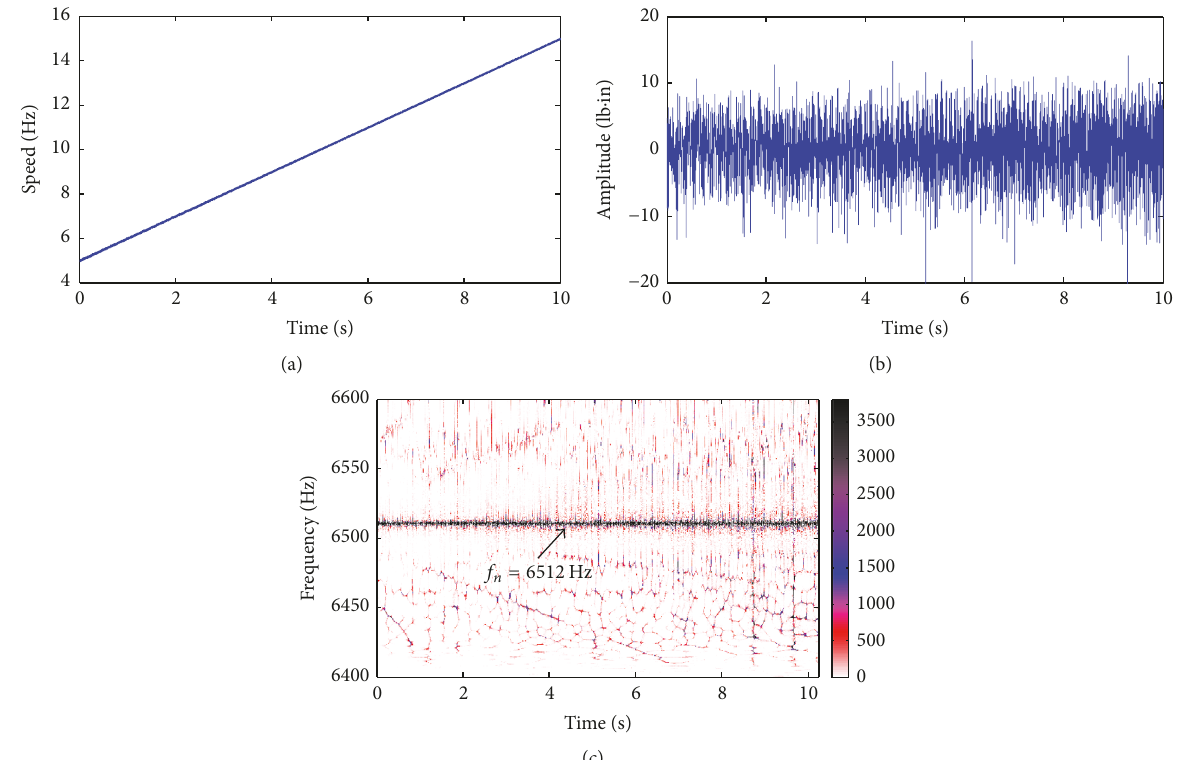
Figure 14: Resonance frequency identification: (a) drive motor speed, (b) detrended torsional vibration signal, and (c) reassigned Morlet